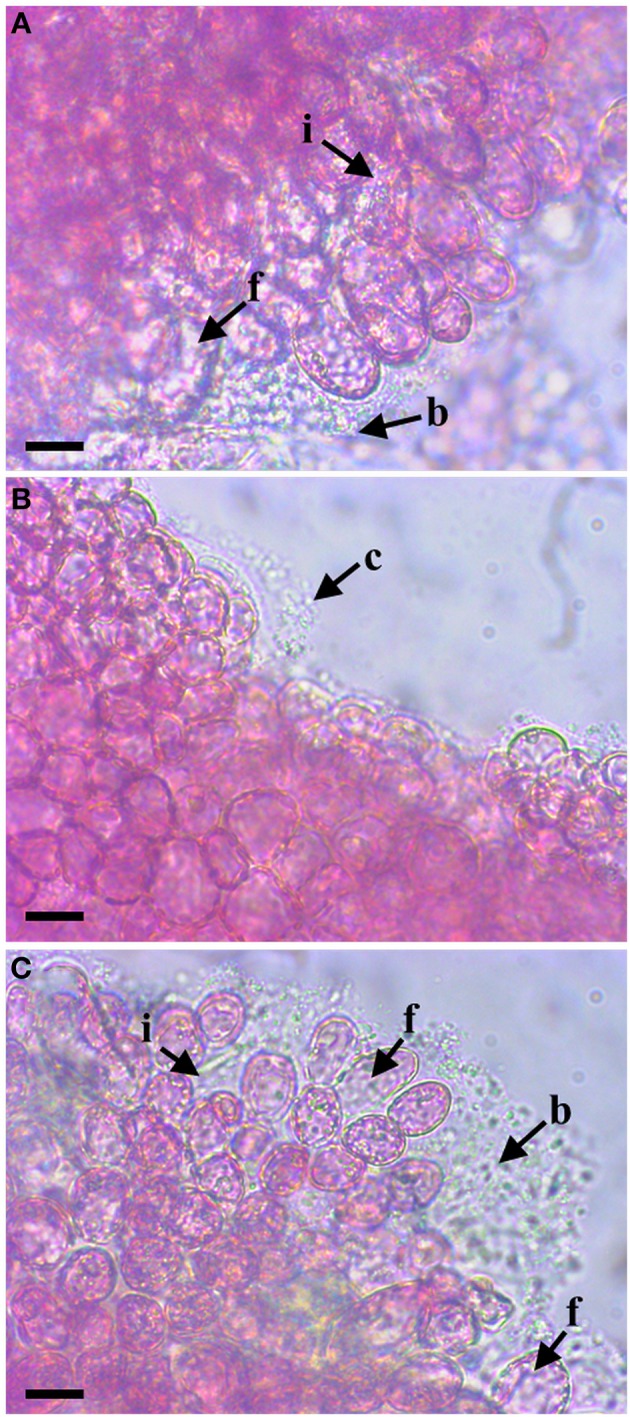
Representative micrographs of D. pulchra sporelings inoculated with N. italica R11 WT (A), ΔvarR (B), and the ΔvarR strain complemented with WT varR (CΔvarR) (C). Sporelings inoculated with WT or CΔvarR bacteria show signs of infection and disease consistent with previous reports (Case et al., 2011). These include damage and bleaching/fading of algal cells (as denoted by f), the presence of a thick biofilm (as denoted by b), and the invasion of bacteria within algal tissue and/or algal cells (as denoted by i) as observed in a and c. The varR allelic exchange mutant (B) exhibited no capacity to cause bleaching or damage to the algal cells, nor was there evidence of bacteria invading the algal tissue or cells (across the triplicate experiments). Moreover sporelings inoculated with ΔvarR
(B) were relatively free from bacterial biofilms with only the occasional thin biofilm being observed (C). Scale bar = 10 μm.